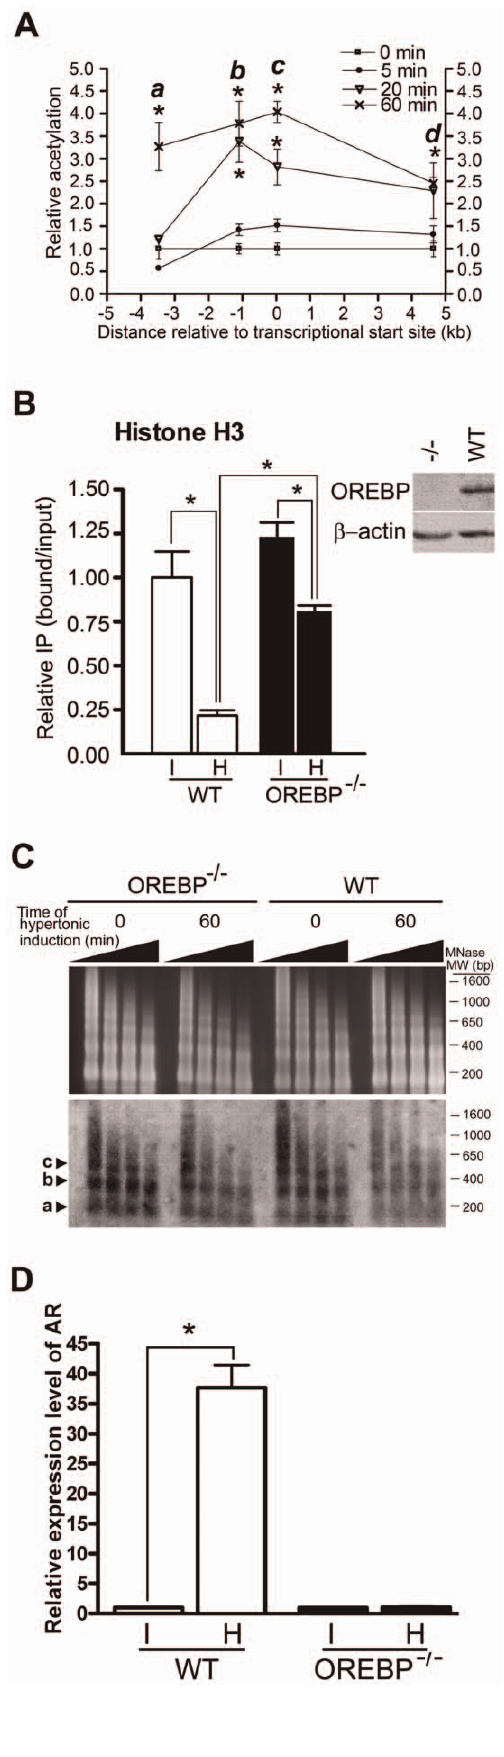
Figure 4. Histone acetylations and histone occupancy at the AR gene in response to hypertonicity. (A) Histone H4 hyperacetylation at the AR gene in response to hypertonic stress. Cells were induced with hypertonic stress, and ChIP was conducted with antibodies against acetylated histone H4 and histone H4. DNA was analyzed by real-time PCR using AR INTER (a), AR ORE (b), AR PP (c), and AR EX2 (d) primer pair respectively. The ratio of immunoprecipitated DNA to total input DNA for each of the antibodies was determined. The value for the level of acetylation of histone H4 was divided by H4 occupancy value. Values at time 0 were set to be 1.0. *, p , 0.01 by one-way ANOVA. (B) Histone occupancy at the ORE region of WT and OREBP 2 / 2 MEFs. Cells were maintained under isotonicity or treated with hypertonicity for 1 hr. ChIP was conducted with antibody against histone H3. DNA was analyzed by real-time PCR using AR ORE primer pair. The results are presented as the ratio of immunoprecipitated DNA to total input DNA and normalized to the value of WT MEFs maintained under isotonicity. *, p , 0.01 and **, p , 0.001 by one-way ANOVA. I, isotonic medium; H, hypertonic medium. Insert, Western blotting analysis of MEFs using anti-OREPB antibodies. (C) MNase assay. (Upper) Nuclei were prepared from WT and OREBP 2 / 2 cells that were induced with hypertonic stress for 0 and 60 min, respectively, and chromatin was subjected to limited digestion with MNase for increasing times. The nucleosome ladder was resolved in agarose gel and visualized by ethidium bromide staining; (Lower). The DNA was subjected to southern blot analysis using a 32 P-labeled probe spanning the ORE (ORE MNase , Fig. 1A). The triangles denote increasing times of MNase digestion. a, mononucleosome; b, dinucleo- somes; c, trinucleosomes. (D) Quantitative analysis of AR transcriptions by RT-PCR. WT and OREBP-/- fibroblasts were incubated in isotonic or hypertonic medium for 16 h. Total RNA was prepared. Relative expression level of AR was determined. The expression level of b -actin was used to normalize the AR expression. Results were expressed as fold change relative to the expression level at time 0. Data are the